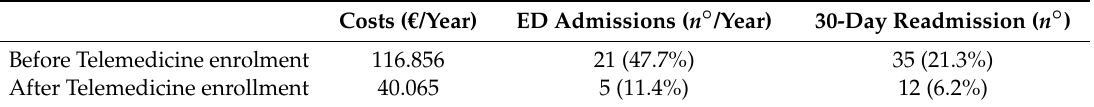
Table 2. Costs and readmissions intra-patient’s comparison between the year before and the year after the enrolment in Telemedicine program ( n = 44 pt).